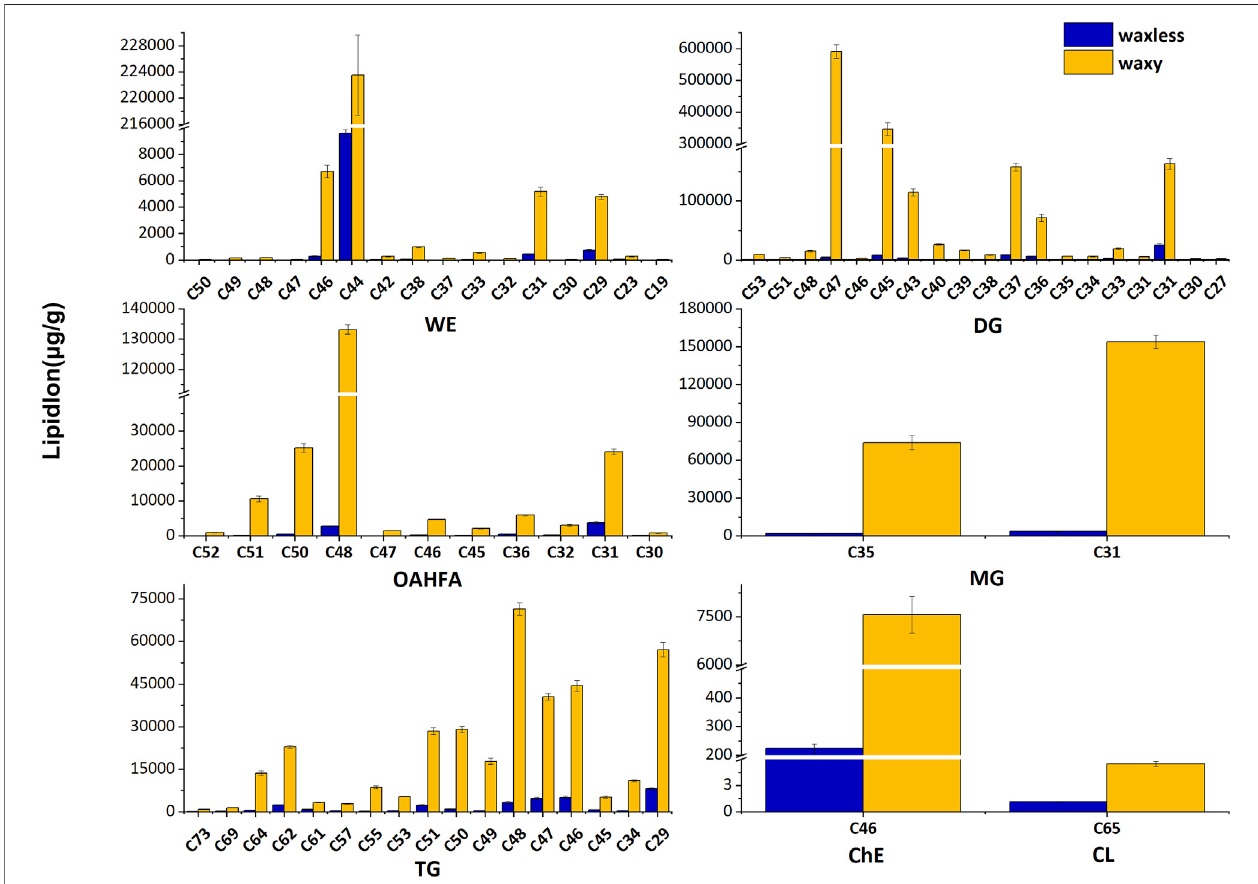
FIGURE 5 | Carbon chain length distribution. Abscissa denotes the lipid molecules with different carbon chain lengths, ordinate indicates lipid ion content, blue is the low-wax mutant waxless , and yellow is the multi-wax mutant waxy .